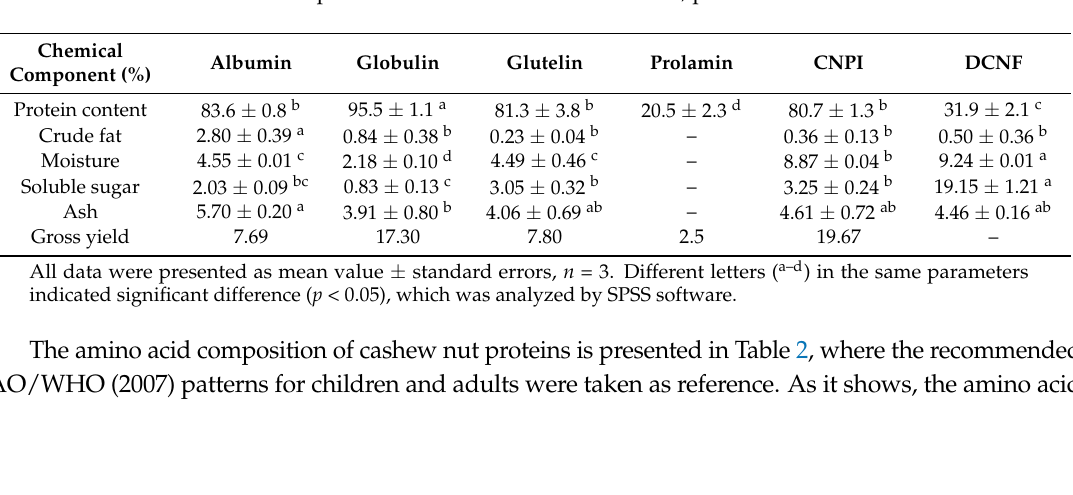
Table 1. Proximate composition of defatted cashew nut flour, protein fractions and